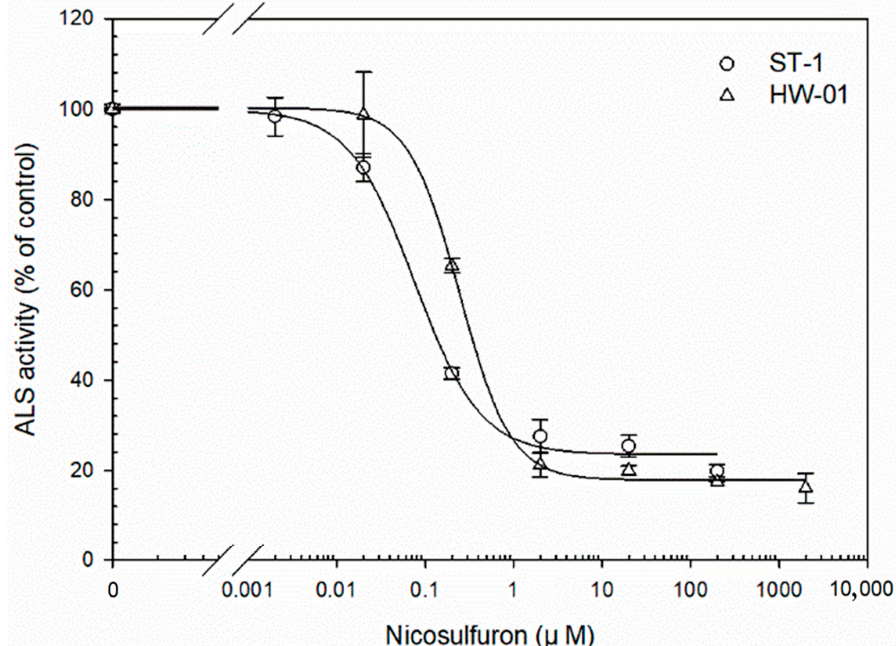
Figure 2. Inhibition of ALS activities in the HW-01 population (R) and ST-1 population (S) to nicosulfuron. The data represent the mean ± SE of two extractions; each treatment was repeated three times.